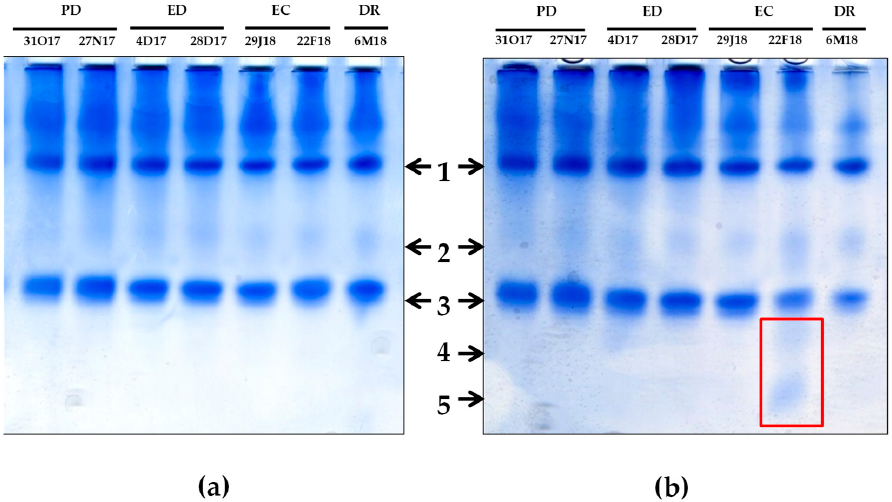
Figure 14. Pattern of peroxidase (POX) isoenzymes in native PAGE for peach ‘GEM020’ flower buds cultivated in two different geographical areas during the dormancy cycle. ( a )Temperate area; ( b ) Cold area. Numbers (1–5) and arrows indicate bands in increasing order of mobility. Bands 4 and 5, detected only in the cold area, are framed in red. Ten micrograms of proteins per line were loaded.